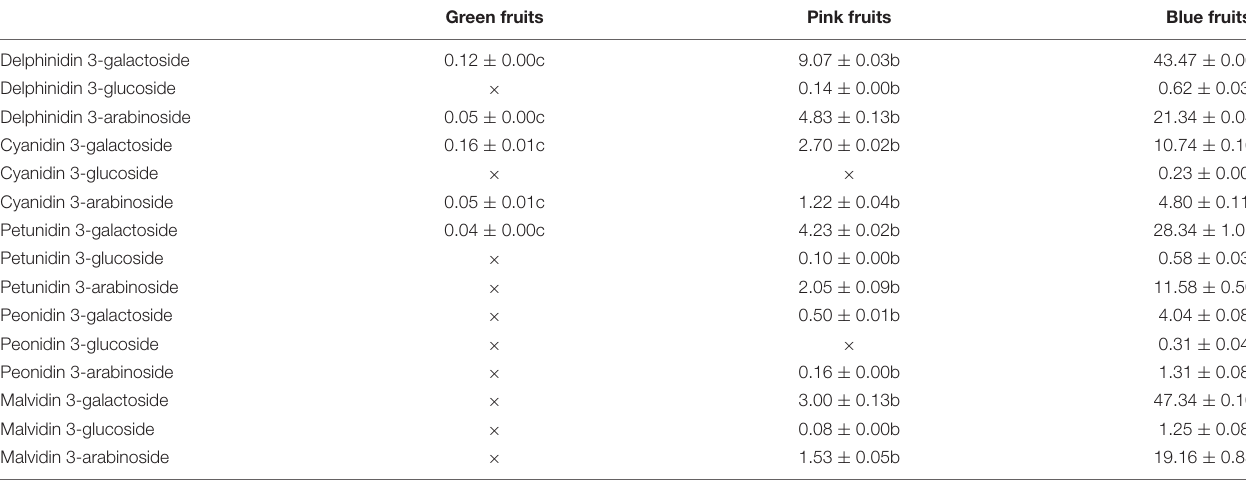
TABLE 2 | Types and contents of anthocyanins in fruits at different developmental stages in blueberries. Green fruits Pink fruits Blue